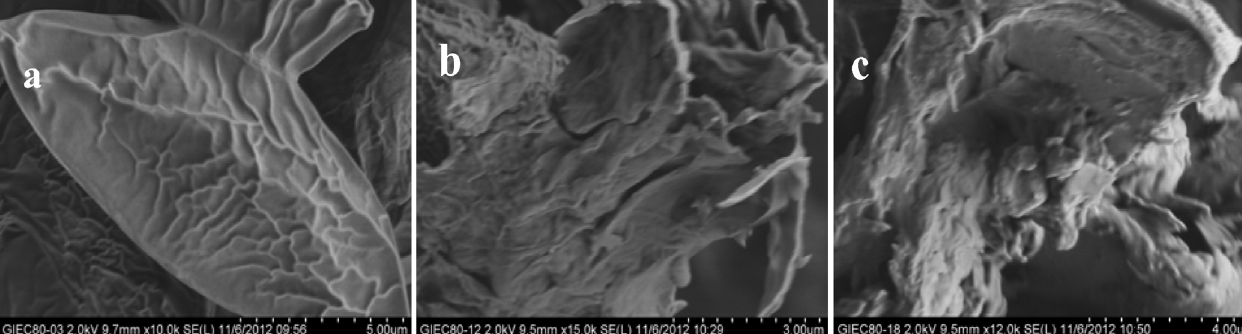
Figure 2. Scanning electron microscope (SEM) micrographs of Scenedesmus sp. G4 cultures: ( a ) before enzymatic hydrolysis; ( b ) hydrolyzed by enzyme mixtures 60 h, pH = 3.5; and ( c ) hydrolyzed by enzyme mixtures 60 h, pH =